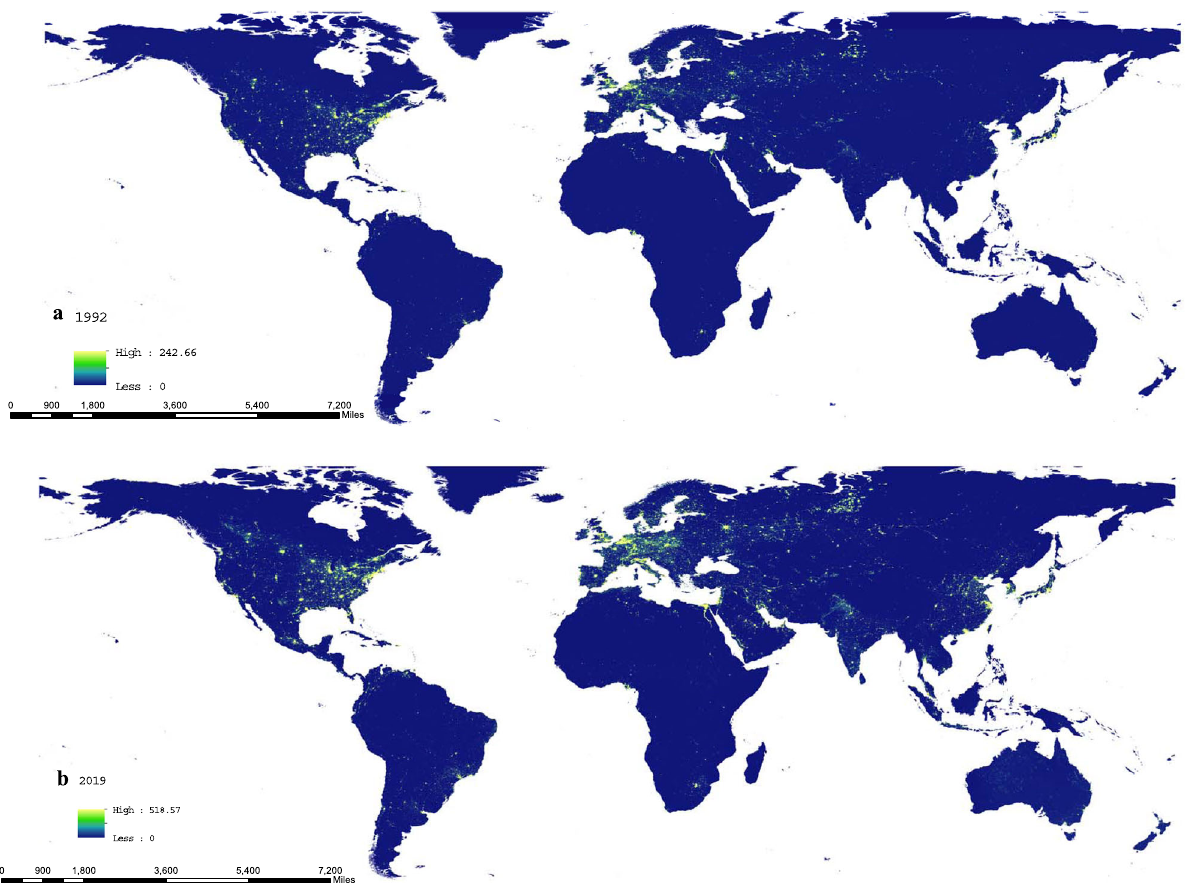
Fig. 1 Global gridded 1 × 1 km global night-time light data in 1992 and 2019. a Global gridded 1 × 1 km global night-time light data in 1992. b Global gridded 1 × 1 km global night-time light data in